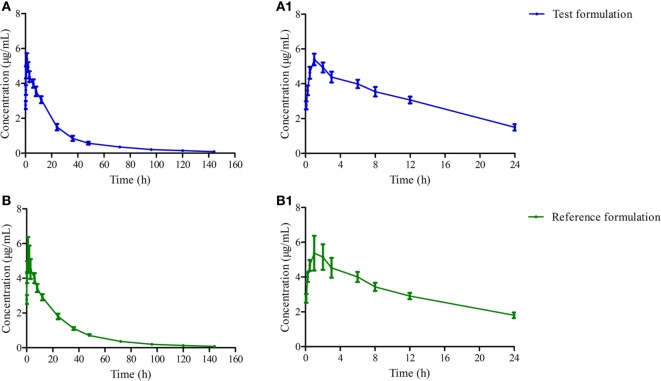
The mean concentration time curves of test and reference formulations in plasma after i.m. (A) present the test one, (A1) present amplification of panel (A) at 0–24 h, (B) present the reference one, (B1) present amplification of panel (B) at 0–24 h.